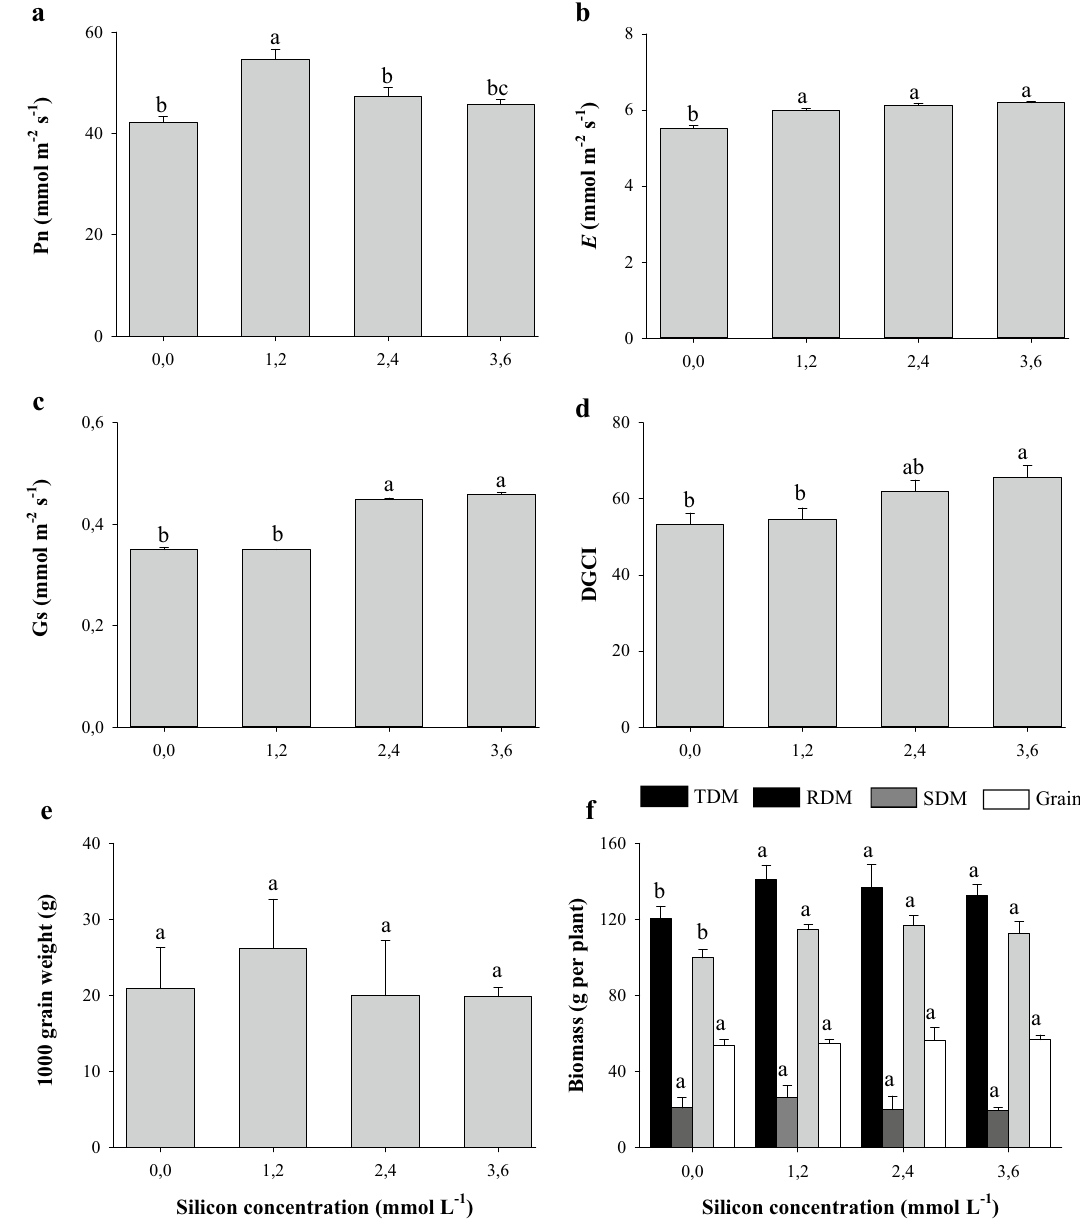
Figure 4. Photosynthetic rate ( A ) ( a ), transpiration ( E ) ( b ), stomatal conductance ( gs ) ( c ), dark green color index (DGCI) ( d ), thousand grain weight ( e ), and biomass production (grains; root: RDM; shoot: SDM, total: TDM) ( f ) of grain sorghum plants under different silicon (Si) concentrations. Error bars over the dots indicate the standard error of the mean. *, **, and ns—significant at 1%, at 5%, and not significant by the F test,